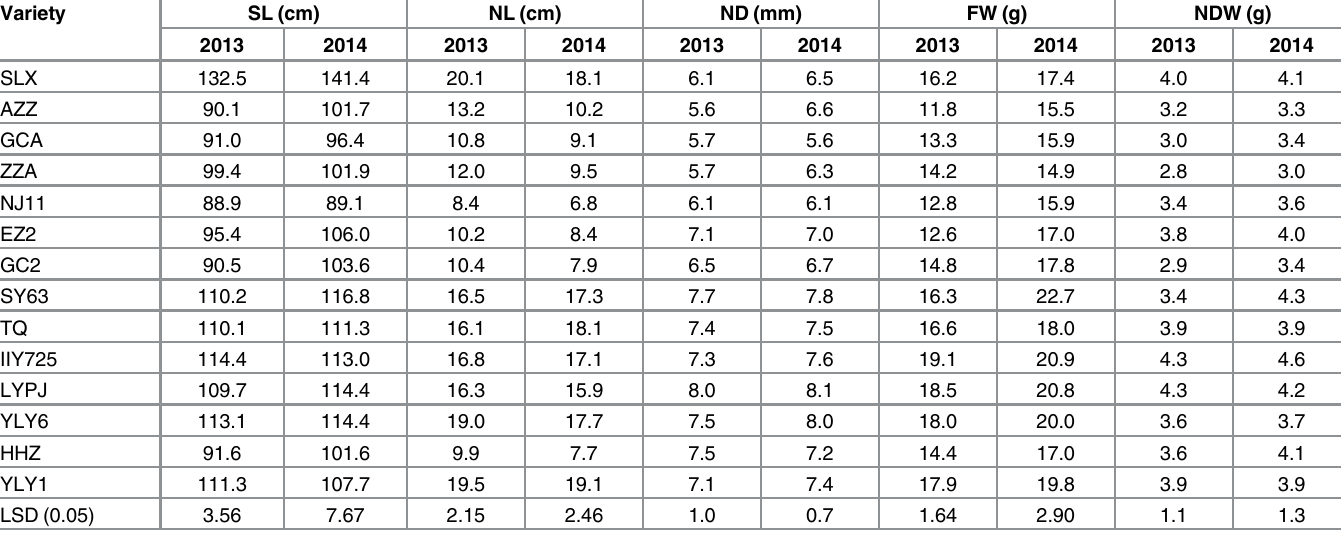
Table 2. Stem length (SL), N 3 internode length (NL), N 3 internode diameter (ND), Stem fresh weight (FW) and N 3 internode dry weight (DW) of rice varieties grown in 2013 and 2014 released in different ages since 1930s in